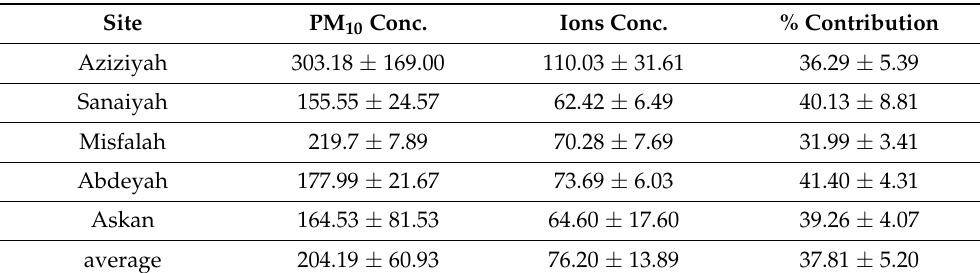
Table 1. Sum of ion concentrations ( µ g/m 3 ) and their percent contribution to PM 10 concentrations ( µ g/m 3 ) at different monitoring sites.